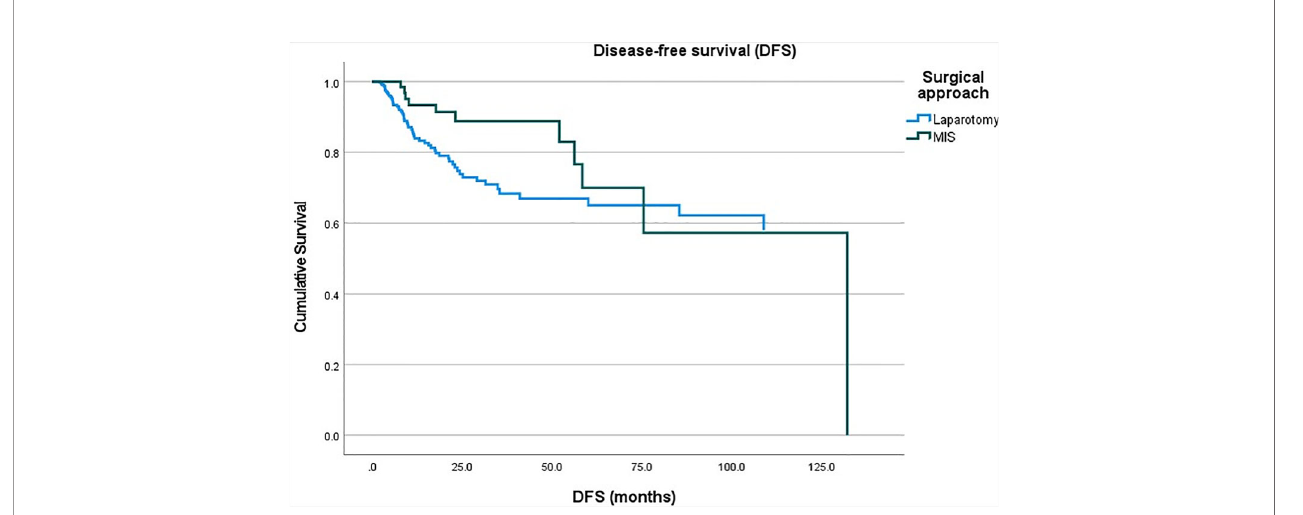
FIGURE 2 | Disease-free survival of the patients with endometrial cancer between the minimally-invasive surgery (MIS) group vs . laparotomy